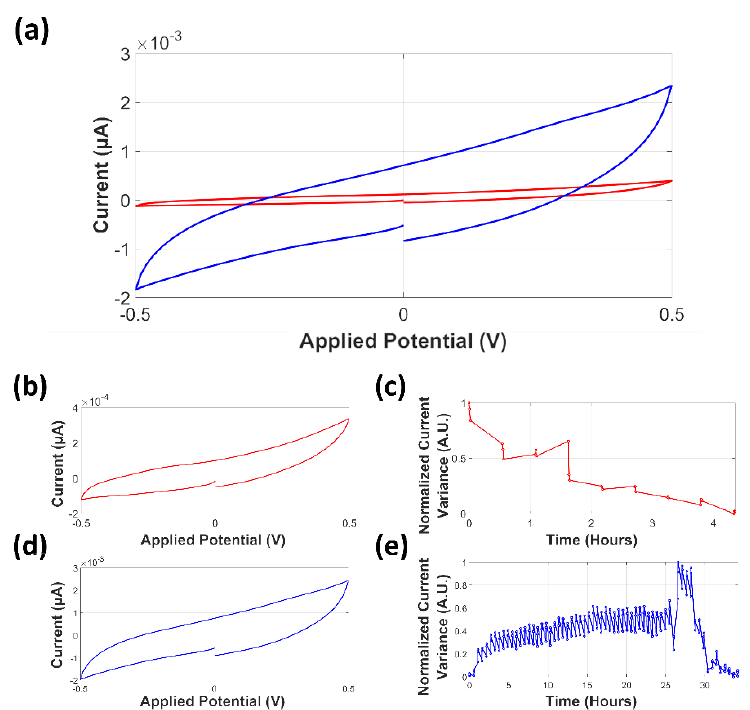
Figure 9. Current variance for independent sections of a colonized microsystem determined by the normalized current variance analysis. ( a ) Mean CV response for the microsystem before (red line) and after (blue line) the colonization event. ( b ) Isolated mean CV response of the microsystem before the colonization event. ( c ) Normalized current variance of the current response before the colonization event. ( d ) Isolated mean CV response of the microsystem after the colonization event. ( e ) Normalized current variance of the current response after the colonization event.